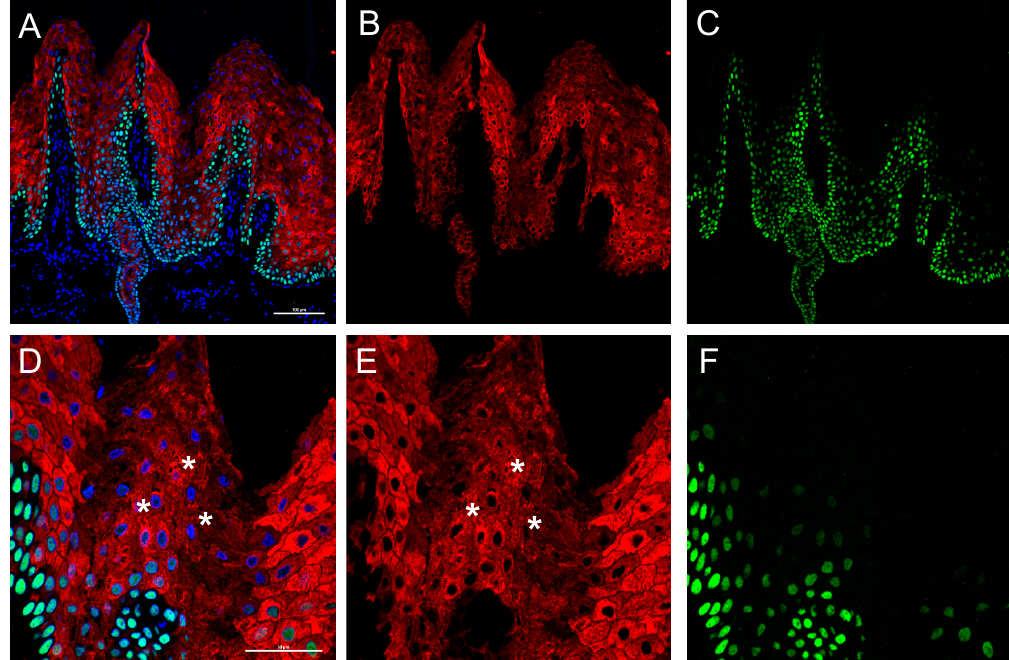
Figure 5. Skin confocal immunofluorescence analysis. Staining for p63 (Green) and K1 (Red). ( A ) p63 and K1 staining merged with DAPI (Blue) ( B ) K1 single channel. ( C ) p63 single channel ( A – C , 20 × objective). ( D ) High magnification capture (60 × objective) showing nuclear localization of p63 and K1 filament clumping (stars, please see high magnification capture furnished in Figure S1); scale bars = 50 μ m. ( E ) K1 single channel. ( F ) p63 single channel. Immunofluorescence analysis for p63 and K1 antigens. P63 is identified using Alexa fluor ® 488 igG (FITC green fluorescence), laser at 488 nm and 525/50 band pass filter while K1 with Alexa fluor ® 568 igG (TRITC red fluorescence), laser at 561 nm and 595/50 band pass filter. Nuclei detection was performed using DAPI (Blu fluorescence), laser at 404 nm and 450/50 band pass filter.